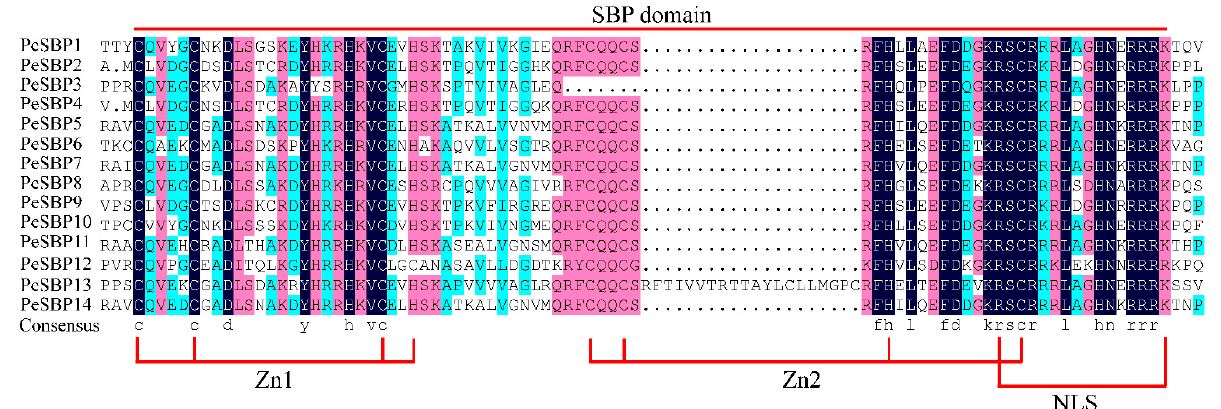
Figure 1. Multiple sequence alignment of SBP domains of PeSBP proteins. The darkblue, purple, and lightblue backgrounds indicate entire conservative residues, 75% conservative residues, and 50% conservative residues respectively.